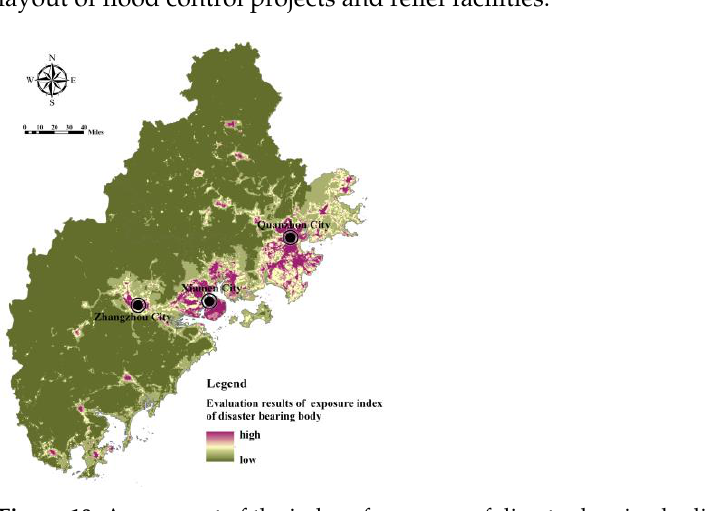
Figure 10. Assessment of the index of exposure of disaster-bearing bodies in Fujian Delta.